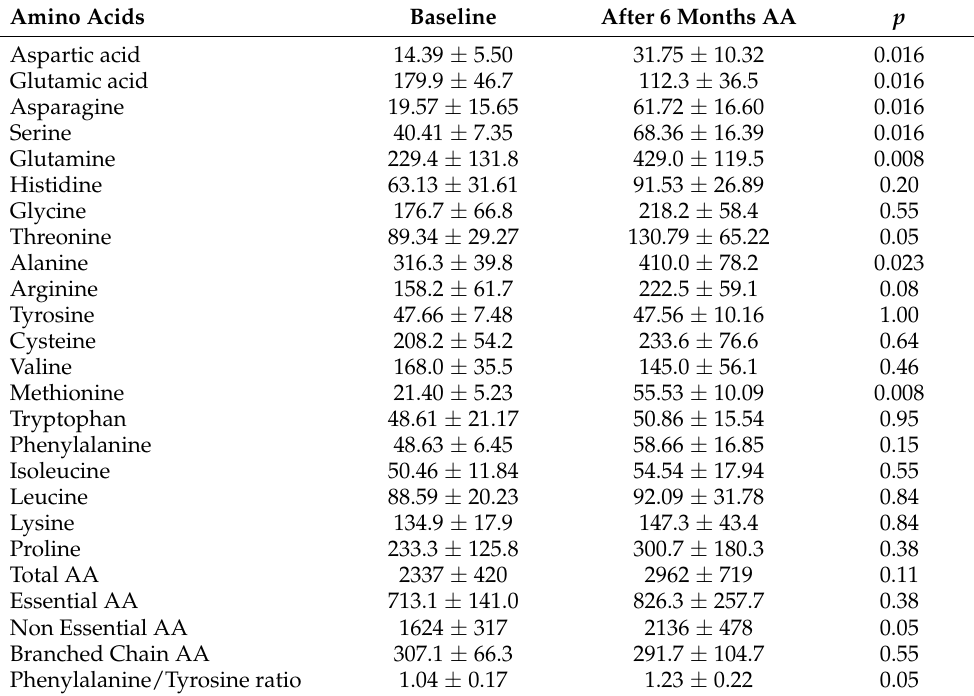
Table 6. Plasma Amino Acid (AA, µ mol/l) profile in Chronic Kidney Disease (CKD) patients at baseline and after 6 months of AA supplementation.